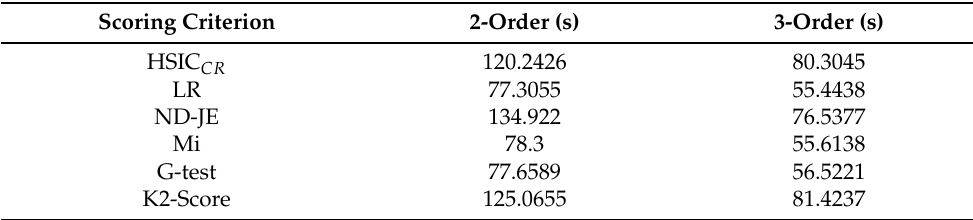
Table 4. Average running time (s) for the six scoring criteria per dataset for both the two-order tests and the three-order tests in the simulation